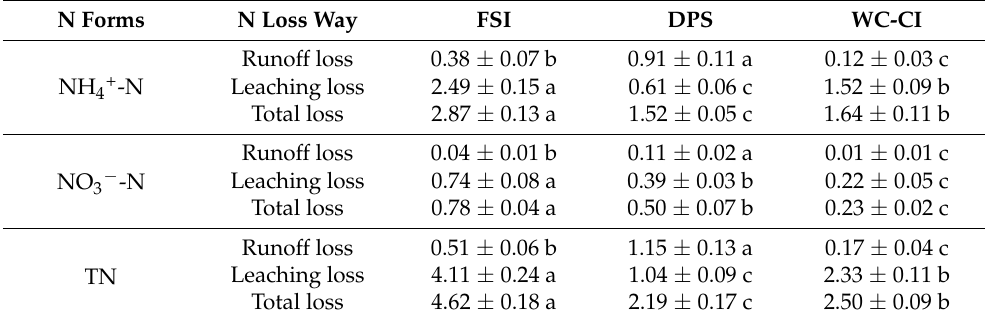
Table 6. The amount of nitrogen losses under different irrigation and drainage modes (kg/ha). N